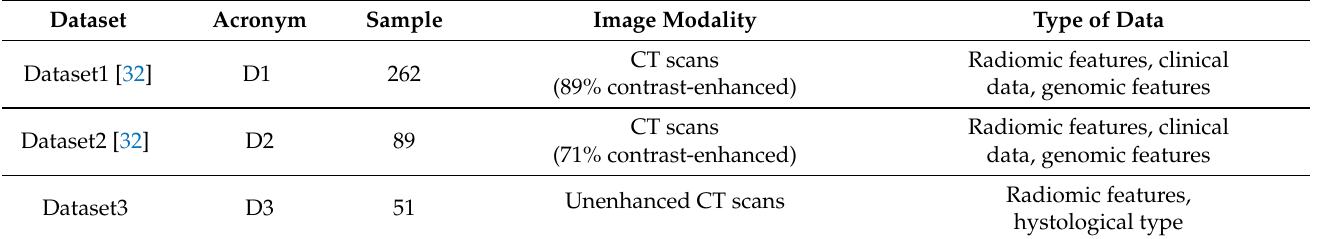
Figure 2. Sample Images with masks from the dataset of the local cohort. Table 1. Dataset